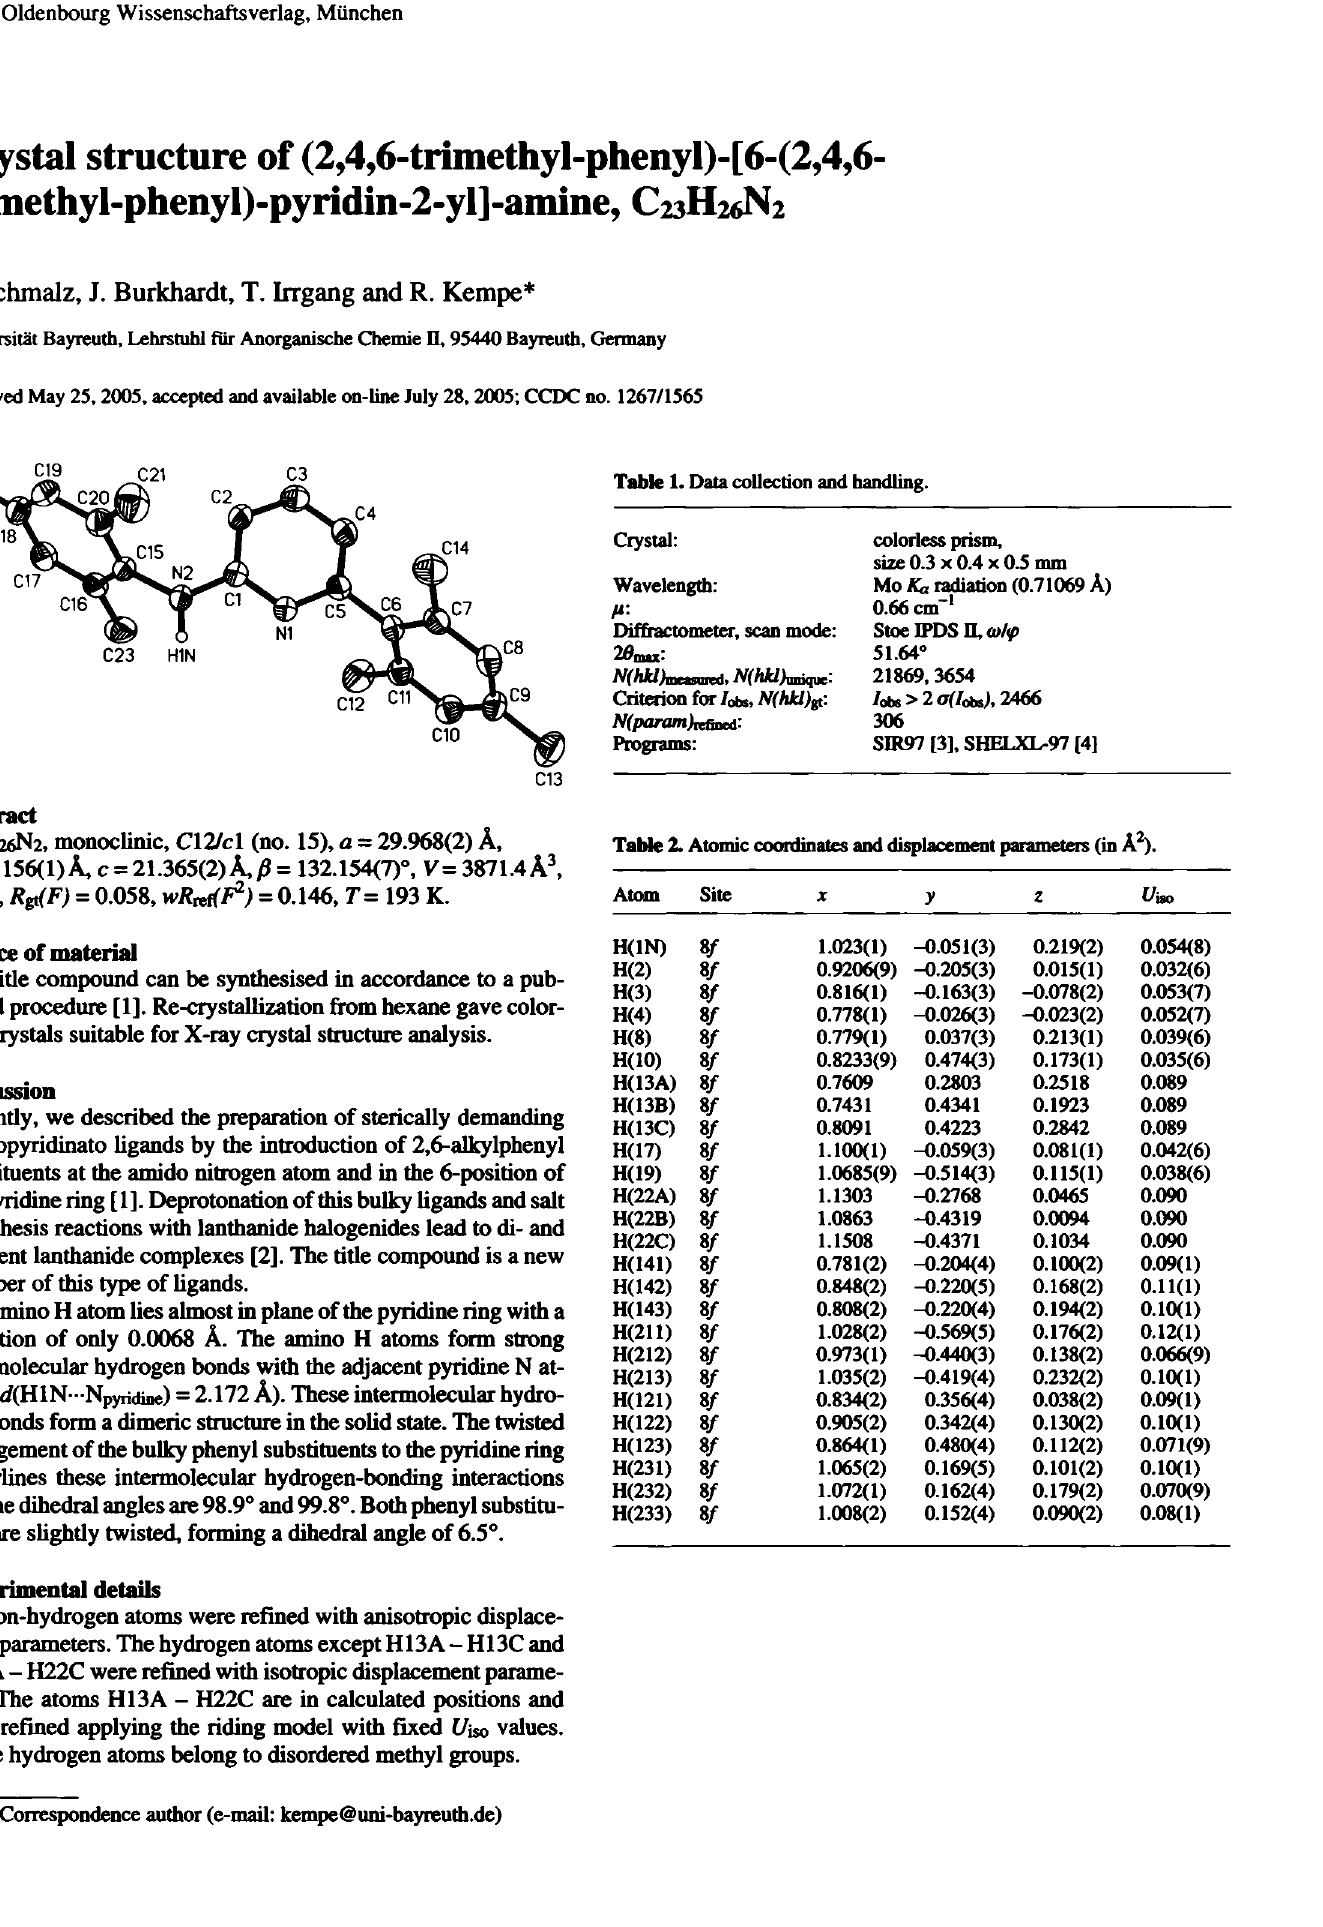
Table 1. Data collection and handling.